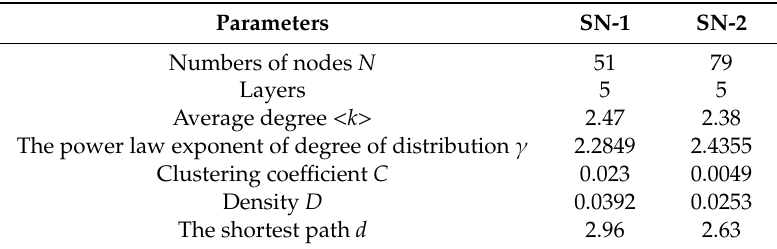
Figure 11. The sample of healthcare resources supply network. Table 2. The parameters of two healthcare resources supply networks.